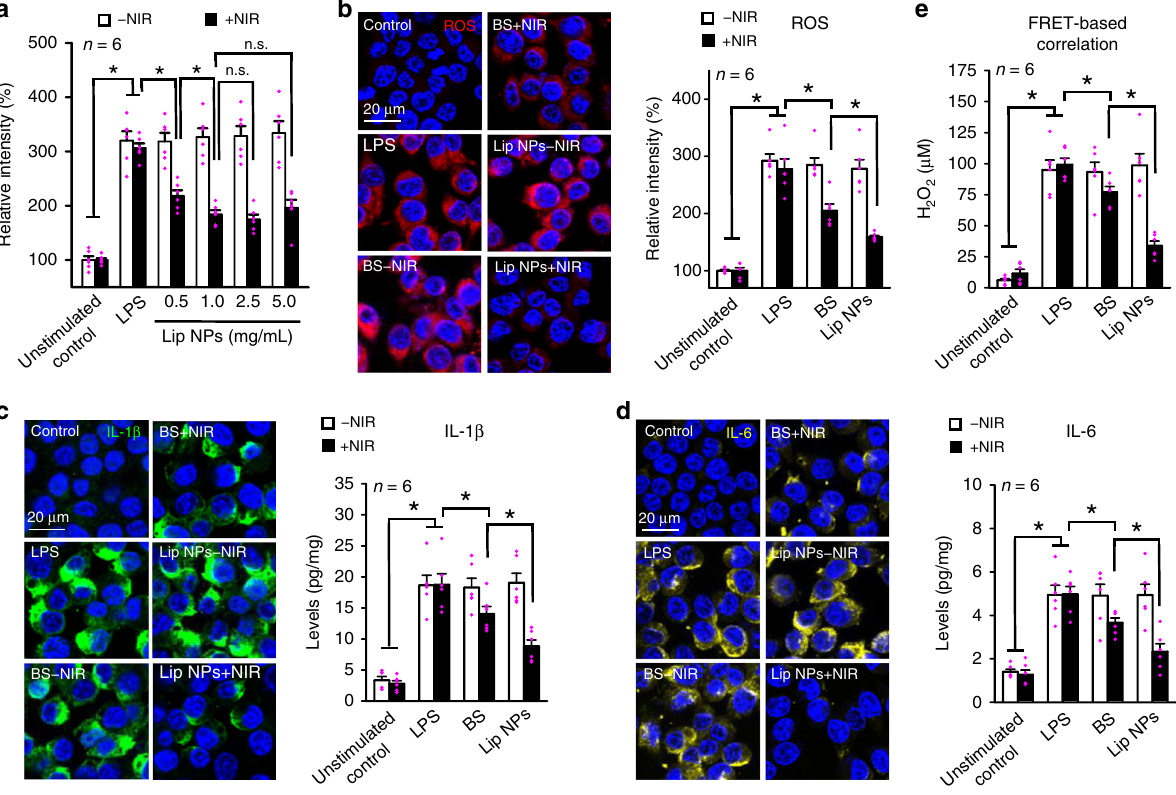
Fig. 6 In vitro ROS scavenging and anti-in fl ammation. a DCF intensities of intracellular ROS levels in LPS-stimulated RAW264.7 cells following treatment with various concentrations of Lip NPs − NIR or Lip NPs + NIR. CLSM images of b cellular ROS, c IL-1 β , d IL-6, and their corresponding intensities after various treatments. e Concentrations of remaining ROS following various treatments, estimated from linear correlation curve of green UCL ( F / F 0 ) intensity against concentration of H 2 O 2 . Data are represented as mean ± SE. Stars indicate signi fi cance in the two-tailed unpaired Student ’ s t test; * P < 0.05. Each pink dot represents one observed data point. Source data are provided as Source Data fi